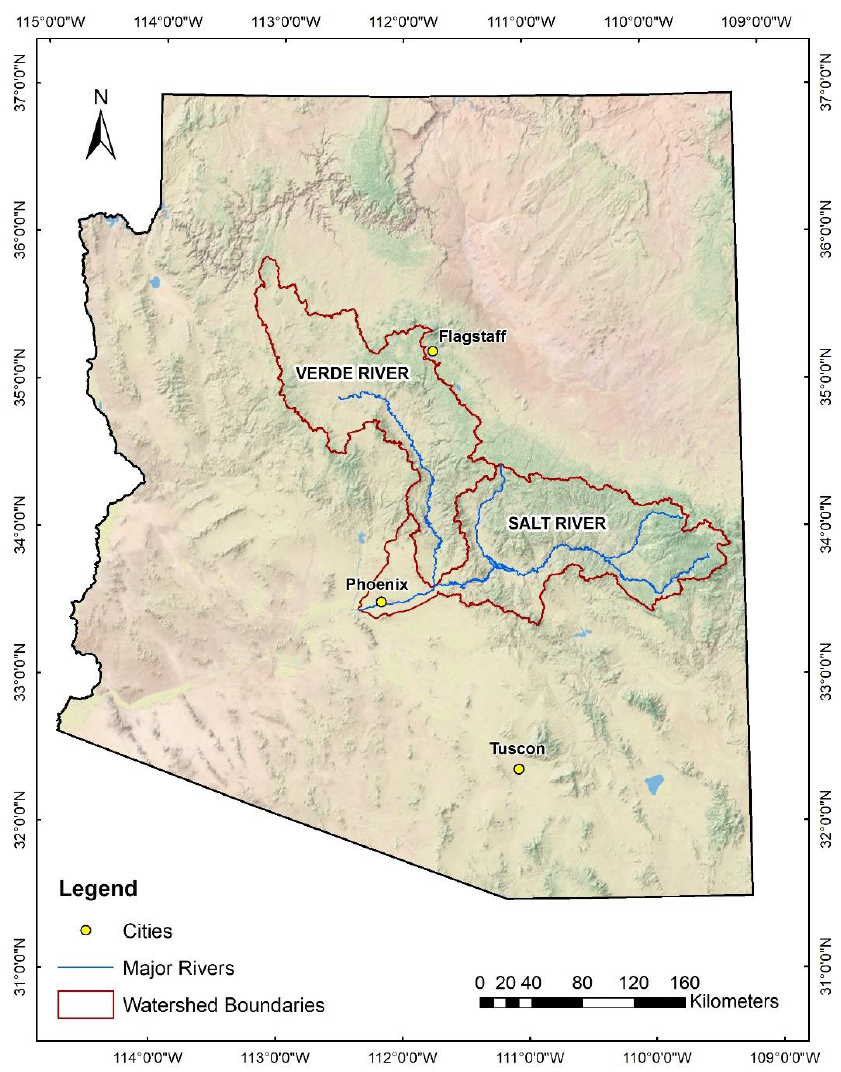
Figure 1. The Salt and Verde River watershed, Arizona, USA. Map layers were created using the North American 1983 Datum, GCS North American 1983, Transverse Mercator projection, and NAD 1983 State Plane Arizona Central FIPS 0202 coordinate system.